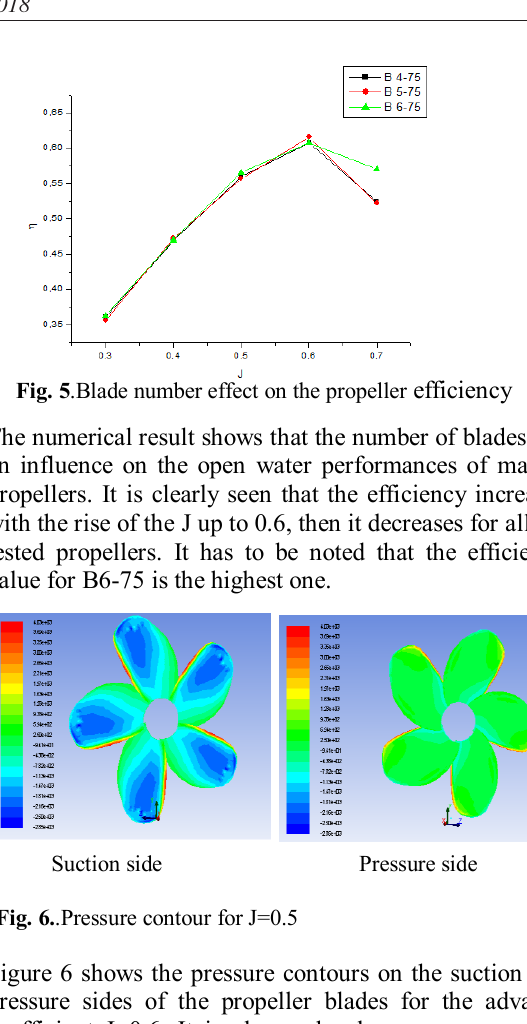
Fig. 6. .Pressure contour for